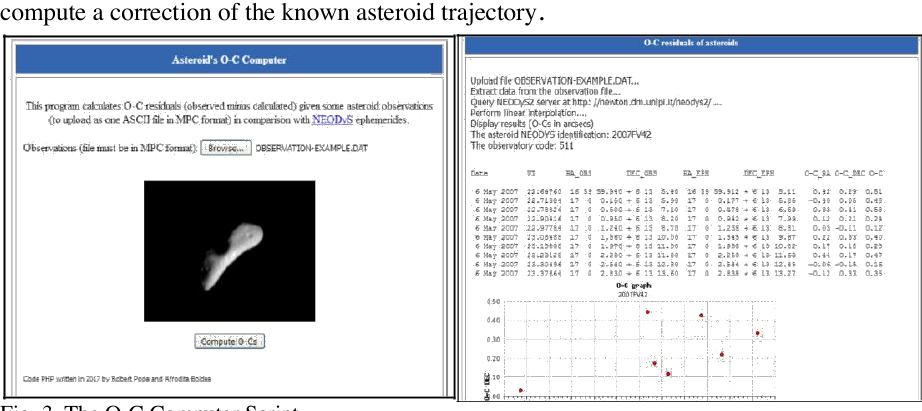
Fig. 3. The O-C Computer Script b. The evaluation of Earth impact risk by an asteroid (The Mu-Eps Scatter Plotter)